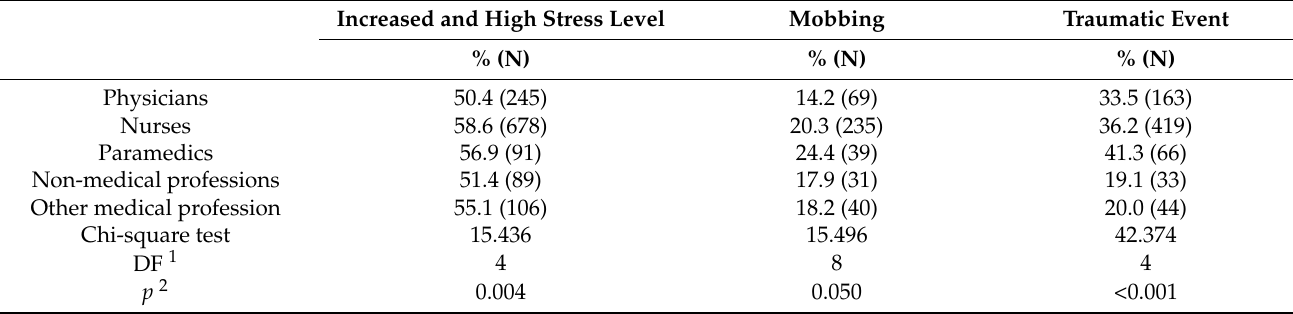
Table 3. The percentage of persons subject to workloads during the COVID-19 pandemic by profes- sion (N = 2196). Increased and High Stress Level Mobbing Traumatic Event % (N) % (N) %